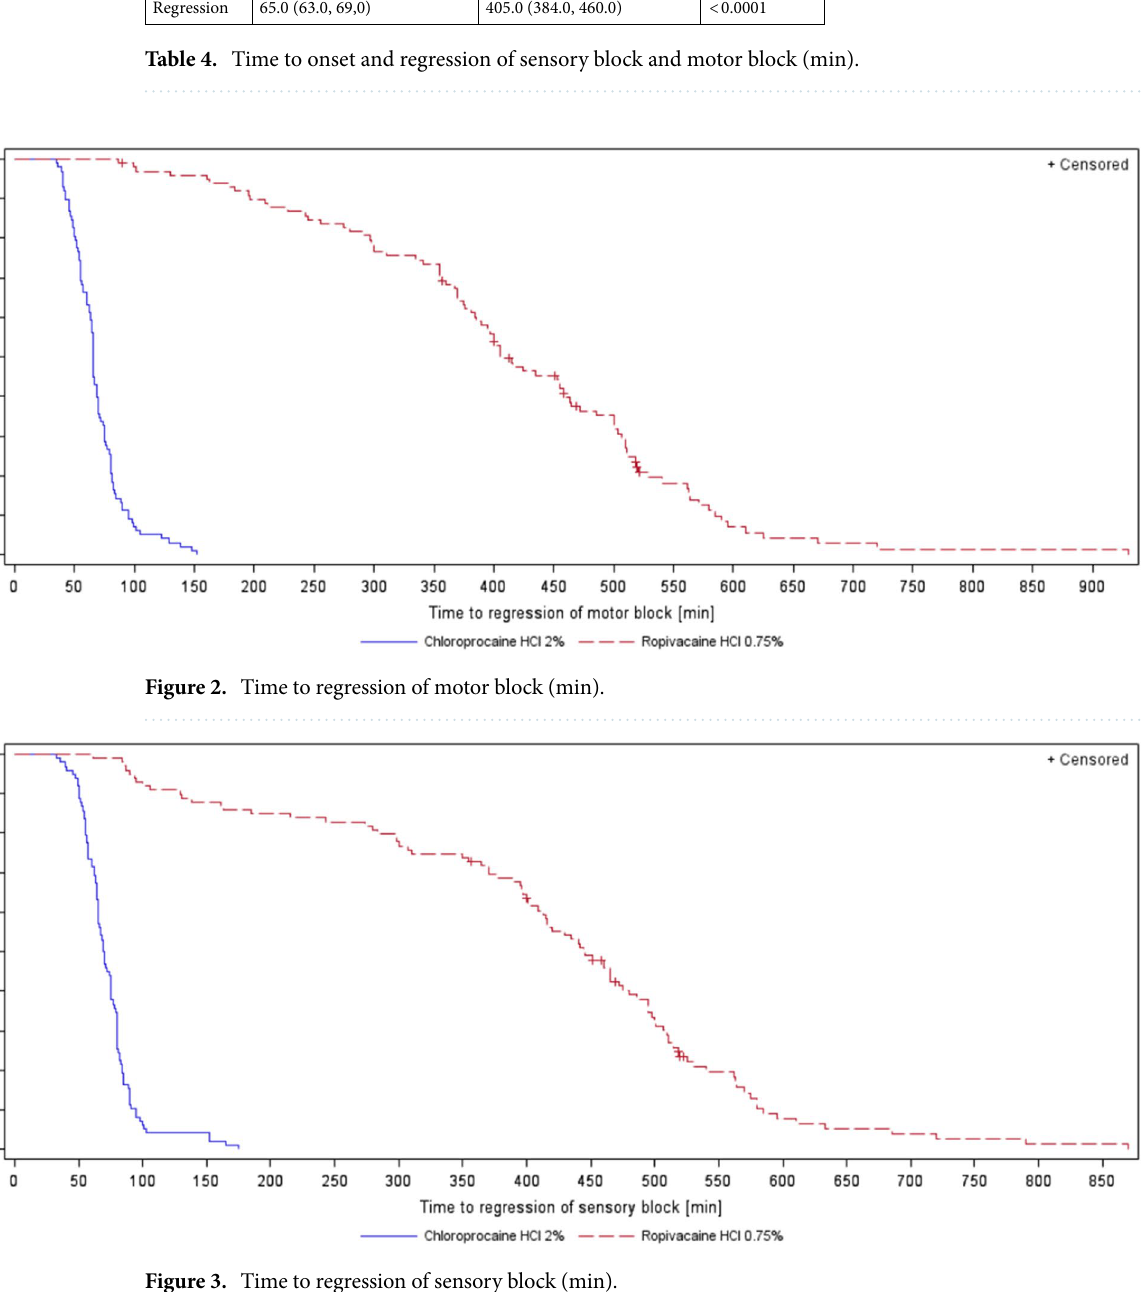
Figure 3. Time to regression of sensory block